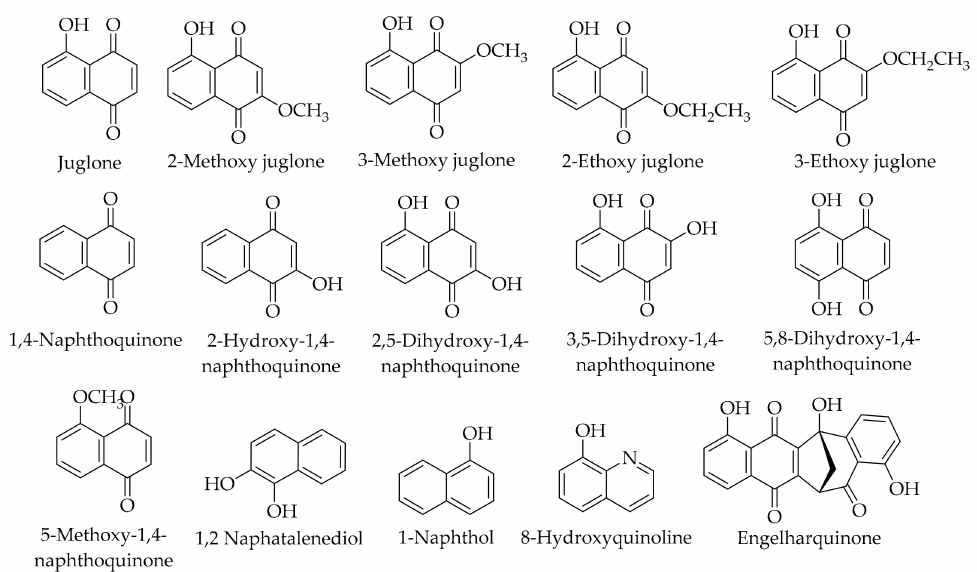
Figure 3. The chemical structures of di ff erent identified, isolated, and quantified naphthoquinones in the walnut green husk.